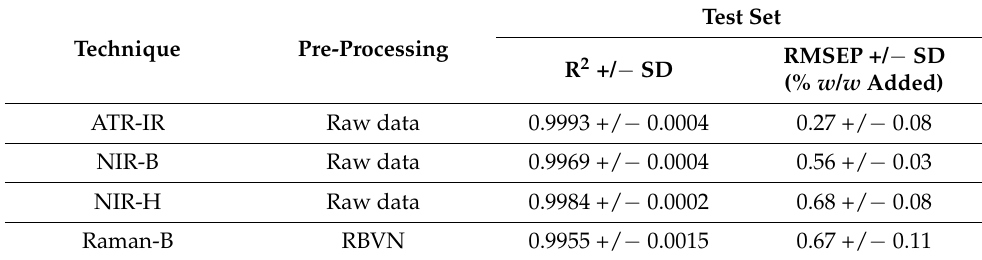
Table 2. PLSR results for the test sets (SET_01, SET_03 and SET_05). Results are reported as mean +/ − standard